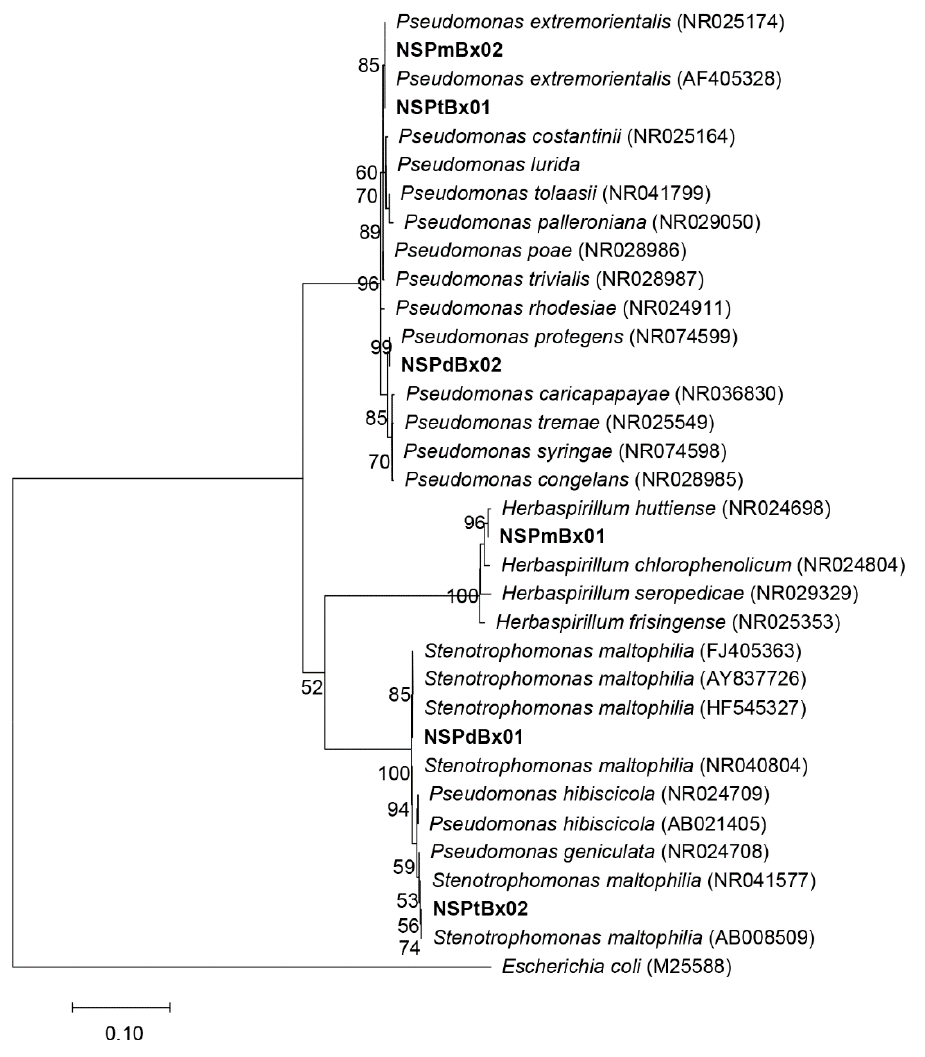
Figure 1. Phylogenetic trees of endo-bacteria isolated from Bursaphelenchus xylophilus based on 16S rDNA. Support values of bootstrap > 50% are indicated at nodes.